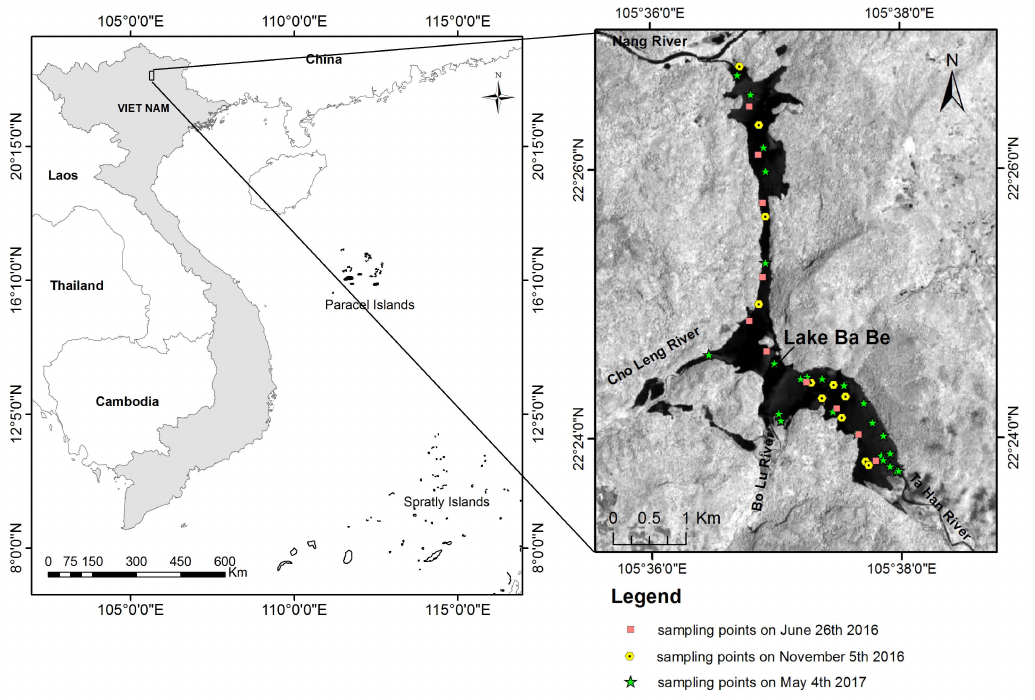
Figure 1. Location of Ba Be Lake in Vietnam and water sampling points over the lake water on three surveyed dates: (1) 4 May 2017; (2) 5 November 2016; and (3) 26 June